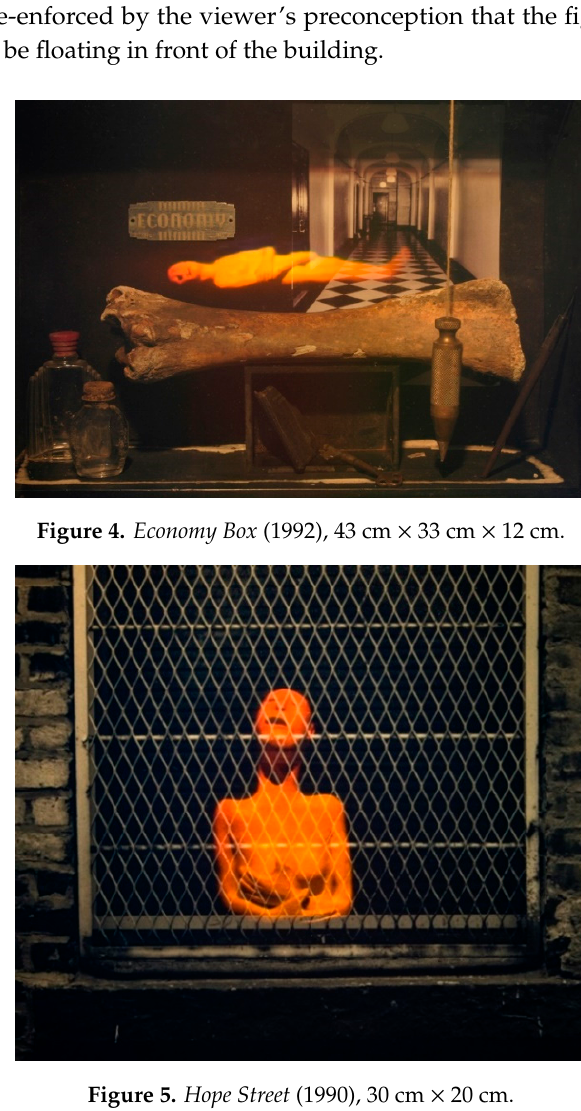
Figure 5. Hope Street (1990), 30 cm × 20 cm.